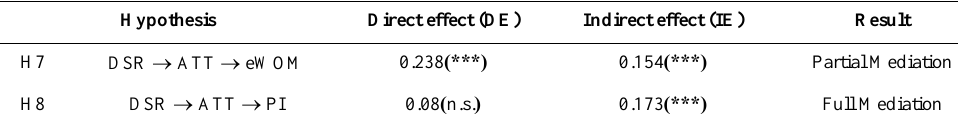
Table 5. Outcomes of mediating effect testing